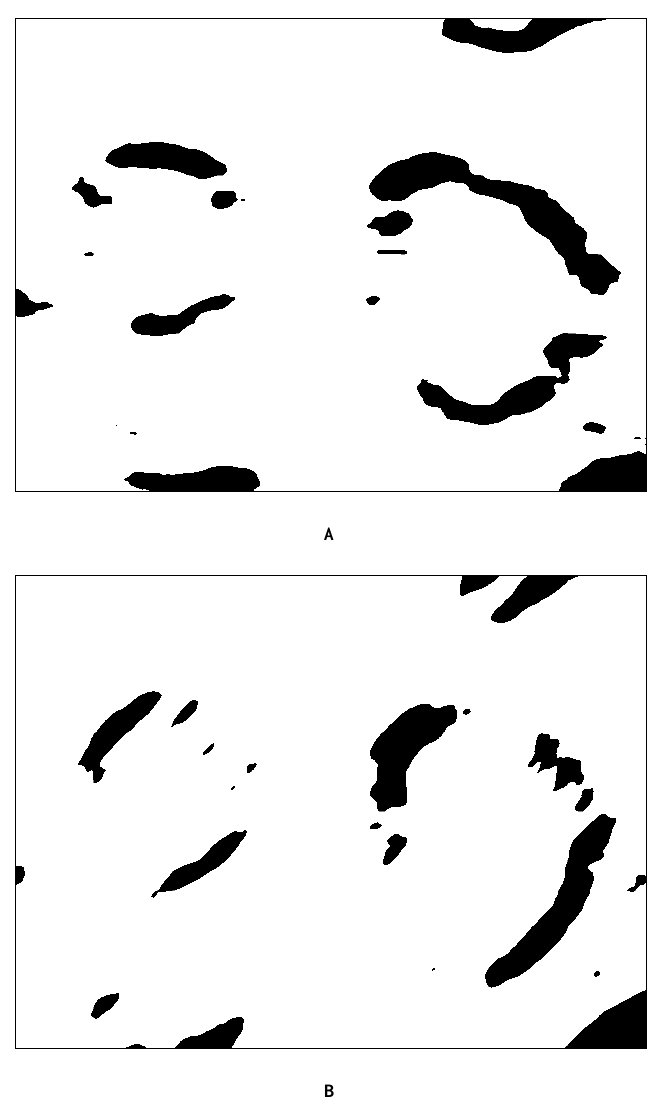
FIGURE 8. (A–D) The segmented gland regions by the four biased median filters with the same window size, but in different rotations as described in the text; (E) the combined segmentation by summing up all the black regions in the four images in (A–D); (F) segmentation with Gaussian